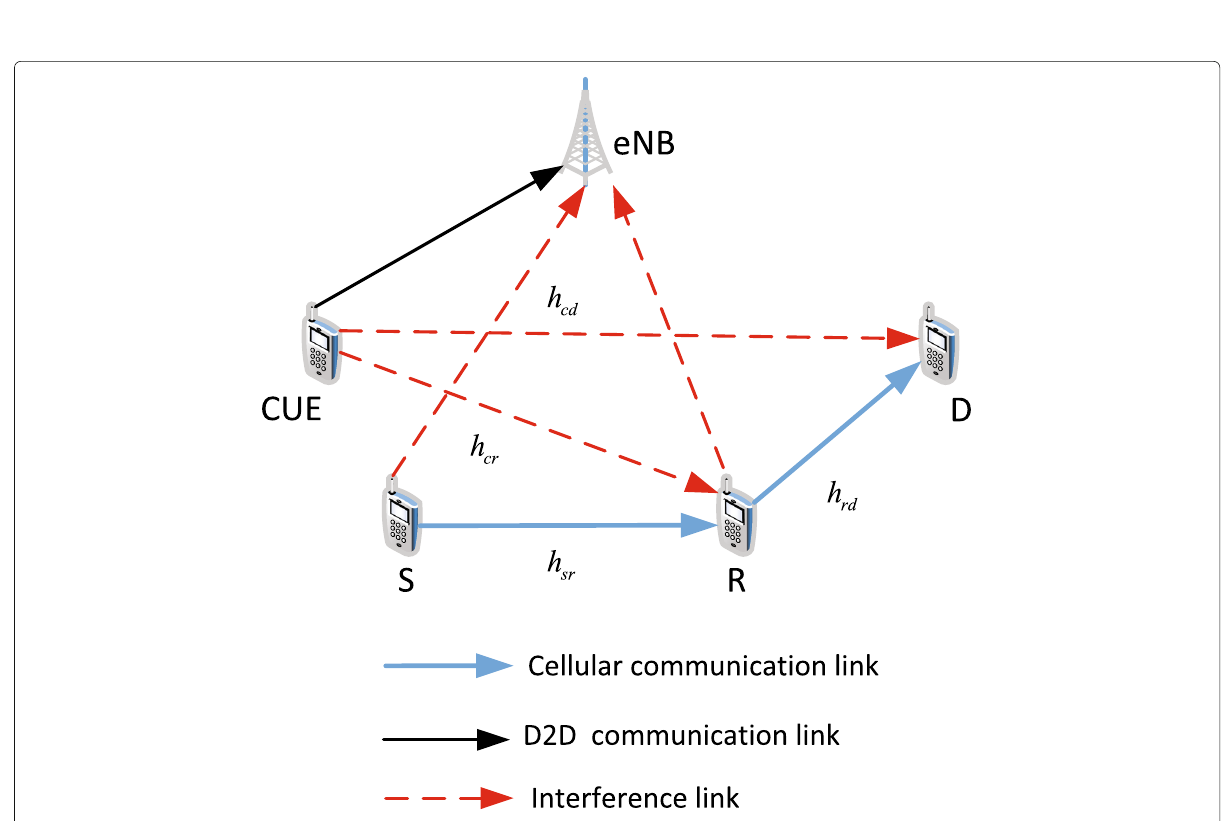
Fig. 2 The specific scenario of RA-D2D communication based on network